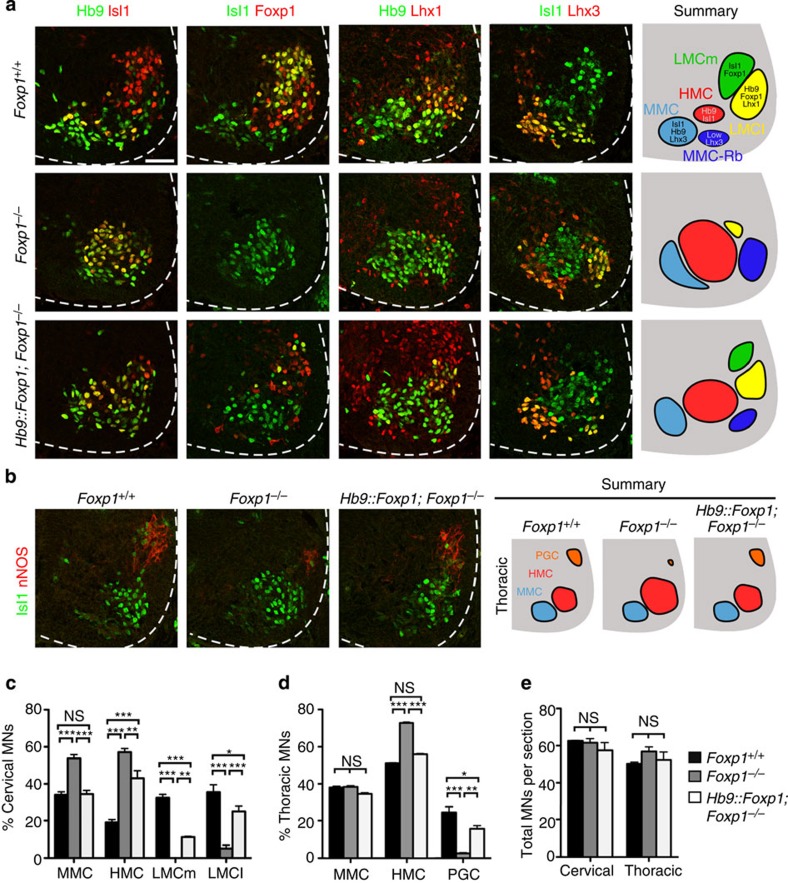
Foxp1 misexpression rescues the Foxp1-mutant phenotype.Analysis of MN subtypes in the ventral horn of E12.5 Foxp+/+, Foxp−/− and Hb9::Foxp1; Foxp1−/− littermate embryo spinal cords. Scale bar, 50 μm. (a) MN subtypes at cervical levels. Foxp1−/− embryos had reduced numbers of LMCm (Isl1+/Foxp1+) and LMCl (Hb9+/Lhx1+) MNs, while HMC (Hb9+/Isl1+) and MMC-rhomboideus (Isl1+/Lhx3low) MNs were expanded compared with Foxp1+/+ embryos13. Hb9::Foxp1; Foxp1−/− embryos had partially restored LMCm and LMCl MNs that resided at the correct lateral positions, and reduced numbers of ectopic HMC and MMC-Rb MNs, compared with Foxp1−/− embryos. Rb, rhomboideus. (b) MN subtypes at thoracic levels. The loss of PGC (Isl1+/nNOS+) MNs in Foxp1−/− embryos was rescued in Hb9::Foxp1; Foxp1−/− embryos. (c) Quantification of MN percentages at cervical levels (mean±s.e.m.; n=3 sections averaged per embryo, 3 embryos per genotype; two-way analysis of variance (ANOVA) with Bonferroni adjustment). MMC MNs: ***P<0.0001. HMC MNs: ***P<0.0001 and **P=0.001. LMCm MNs: ***P<0.0001 and **P=0.006. LMCl MNs: ***P<0.0001 and *P=0.01. NS, not significant, P>0.5. (d) Quantification of MN percentages at thoracic levels (mean±s.e.m.; n=3 sections averaged per embryo, 3 embryos per genotype; two-way ANOVA with Bonferroni adjustment). HMC MNs: ***P<0.0001. PGC MNs: ***P<0.0001, **P=0.0001 and *P=0.0023. NS, not significant, P>0.5. (e) Quantification of total number of MNs per section (mean±s.e.m.; n=3 sections averaged per embryo, 3 embryos per genotype; two-way ANOVA with Bonferroni adjustment). NS, not significant. P>0.5.